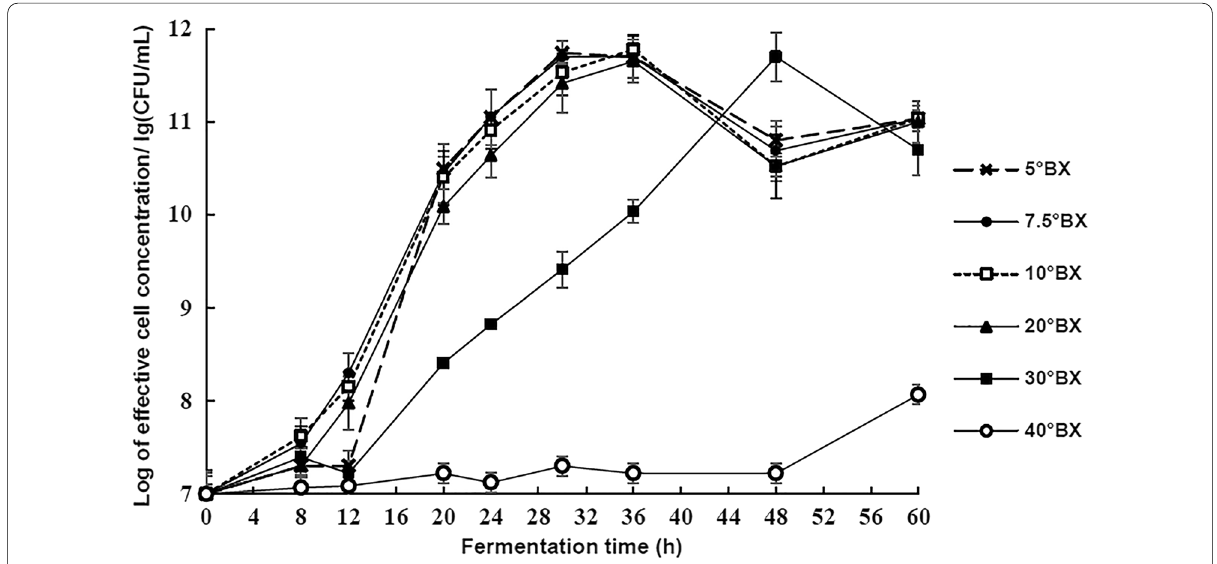
Fig 1 Growth of strain in different concentrations of cane